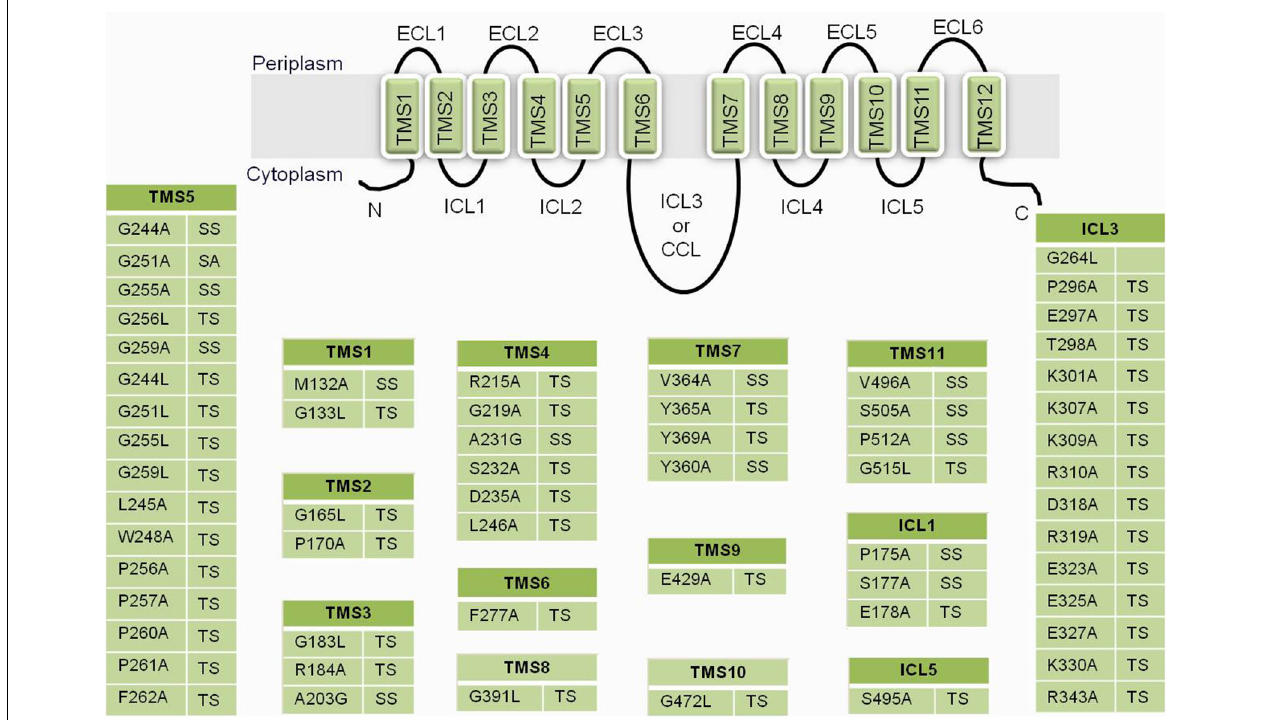
FIGURE 6 | A list of residues from CaMdr1p that upon substitution gave a phenotype. TS, susceptible to all drugs; SS, selectively susceptible; ECL, extracellular loop; TMS, transmembrane segments; ICL, intracellular loops; CCL, central cytoplasmic loop.